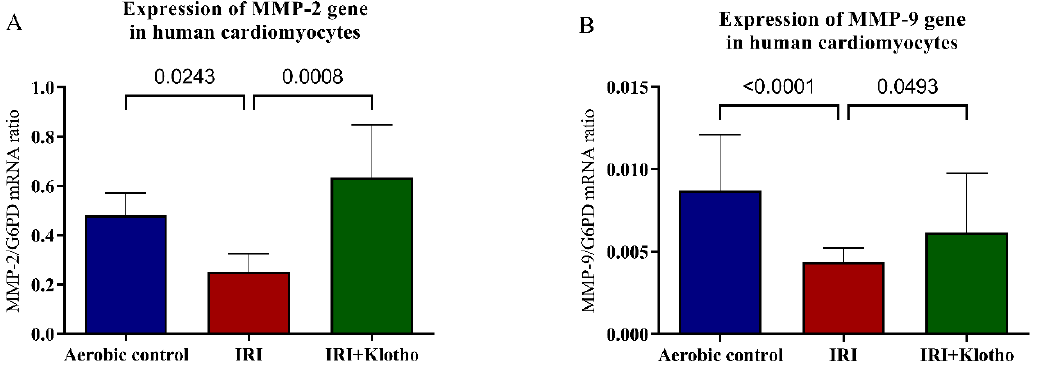
Figure 2. ( A ) Expression of the MMP-2 gene in human cardiomyocytes; n aerobic = 5; n IRI = 5; n IRI+Klotho = 5 ( B ) Expression of the MMP-9 gene in human cardiomyocytes; n aerobic = 14; n IRI = 14; n IRI+Klotho = 10. MMPs mRNA expression was examined by qPCR and normalized to G6PD expression; G6PD—glucose-6-phosphate dehydrogenase; MMP—matrix metalloproteinase; mean ± SD.